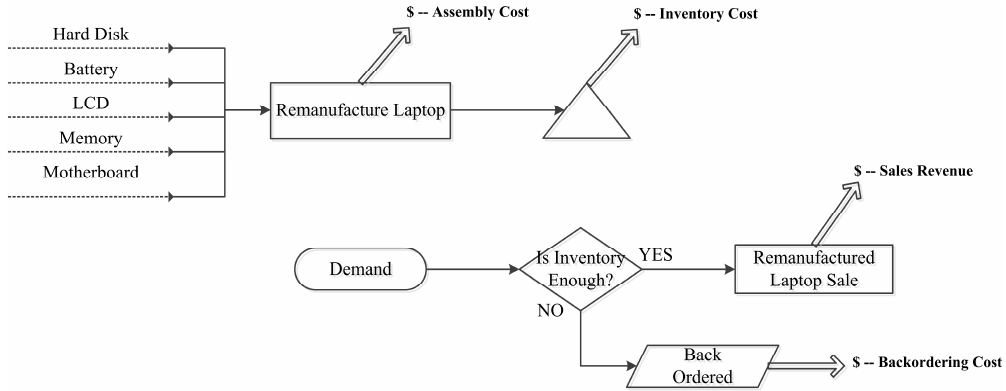
Figure 8. Remanufacturing and demand flow of laptops.